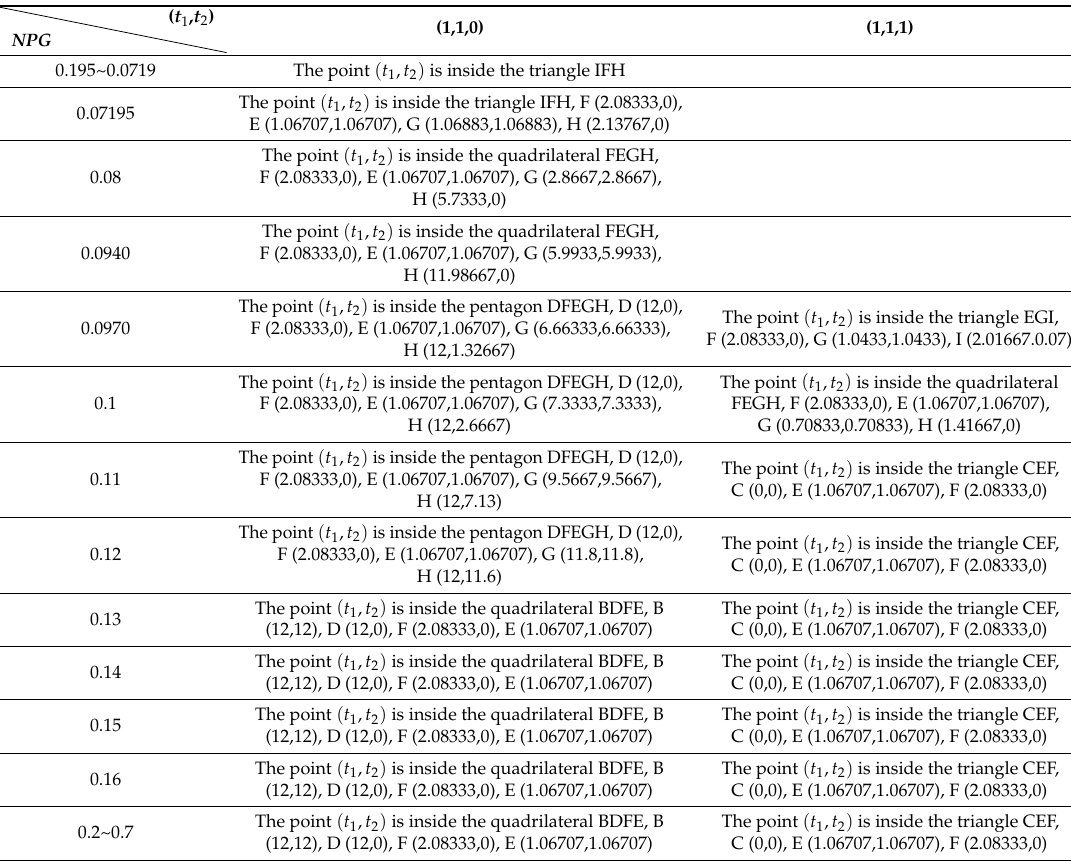
Table A6. Influence of NPG on energy storage charging and discharging time decisions of power grid